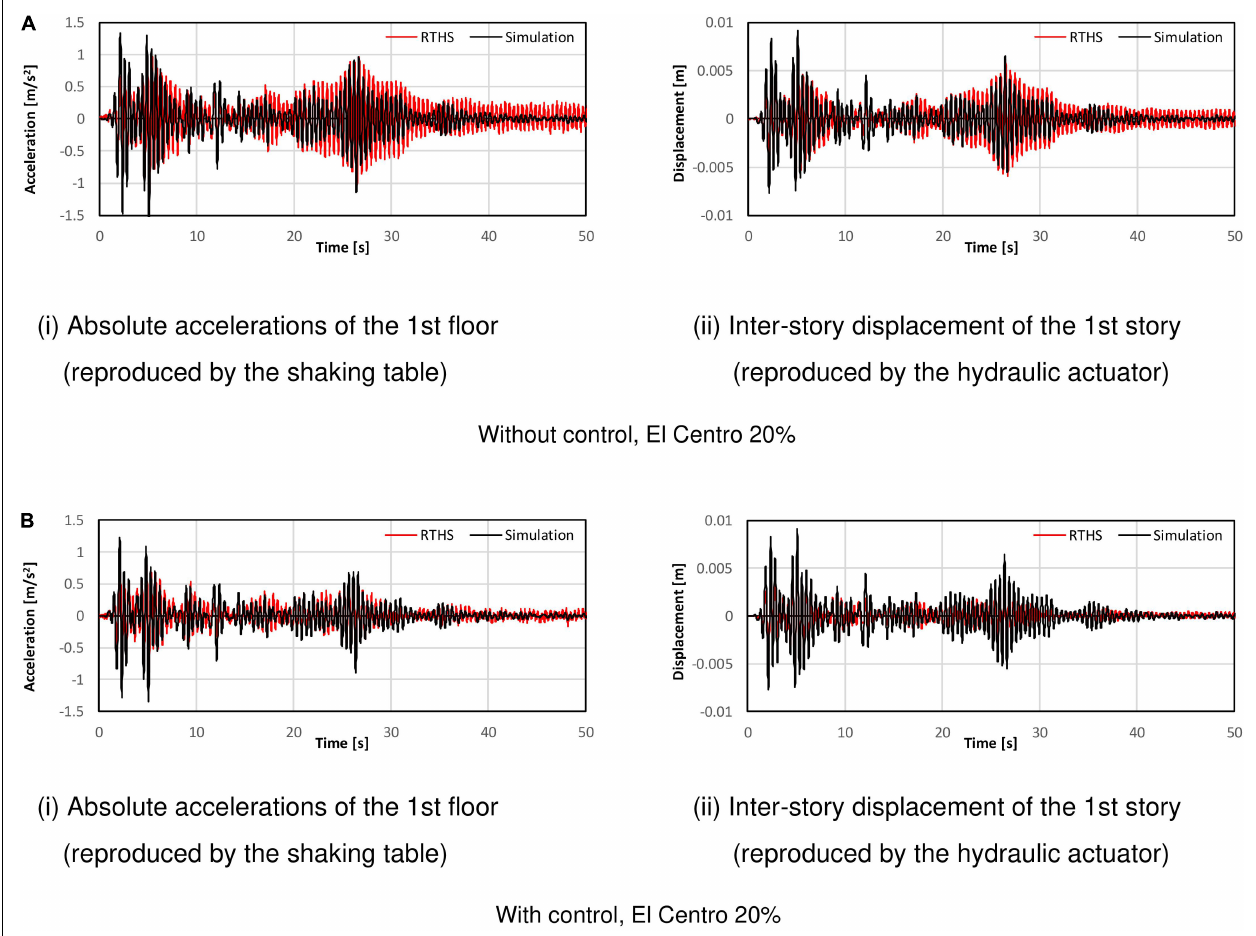
FIGURE 9 | Measured responses of RTHS test vs. pure-simulation results. (A) Without control, El Centro 20%, (i) Absolute accelerations of the 1st floor (reproduced by the shaking table) and (ii) Inter-story displacement of the 1st story (reproduced by the hydraulic actuator). (B) With control, El Centro 20%, (i) Absolute accelerations of the 1st floor (reproduced by the shaking table) (ii) Inter-story displacement of the 1st story (reproduced by the hydraulic actuator).